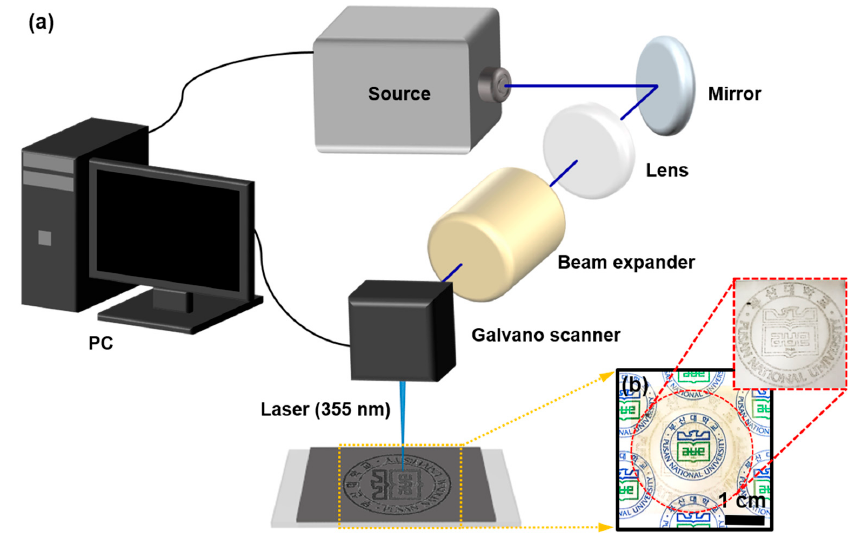
Figure 2. ( a ) Schematic illustration of UV pulse laser system for the reduction of GO. ( b ) Digital image of university logo with sharp contrast (inset) engraved by laser direct writing (LDW) on GO coated PP substrate, showing optical properties with see-through type transparency.